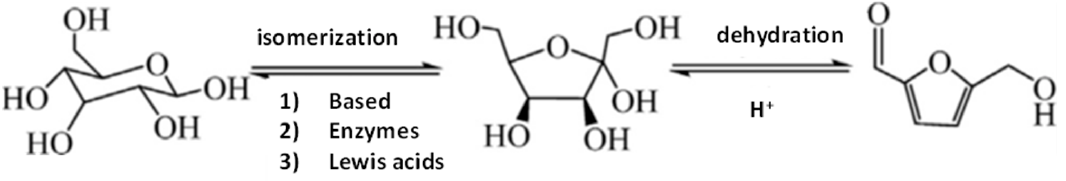
Figure 15. Synthesis of HMF from glucose. Reproduced with permission from ref. [90] Copyright © 2017 Elsevier.